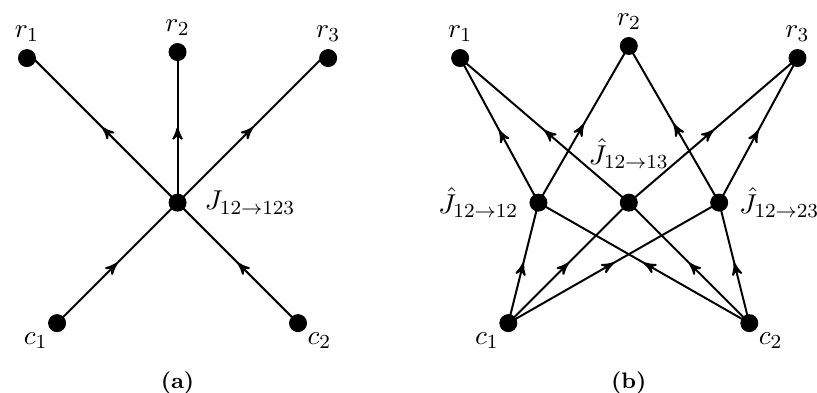
Figure 11. The causal structure of a 2-to-3 bulk scattering con(cid:12)guration with no boundary scatter- ing region. (a) The causal structure in the bulk, where each input point may signal an intermediary region that may signal all three output points. (b) The causal structure in the boundary, where each input point may signal intermediary regions that may signal two of the three output